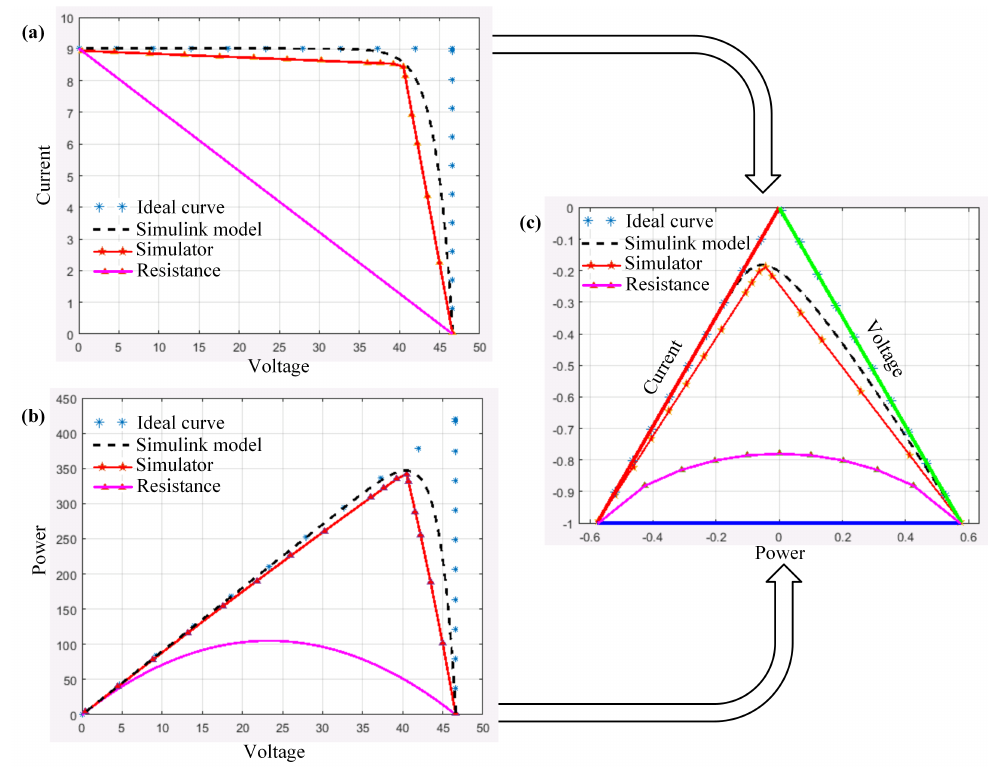
Figure 16. Visualizing the curves ( a ) Current versus Voltage curve; ( b ) Power versus Voltage curve; ( c ) Power versus Current versus Voltage curve in